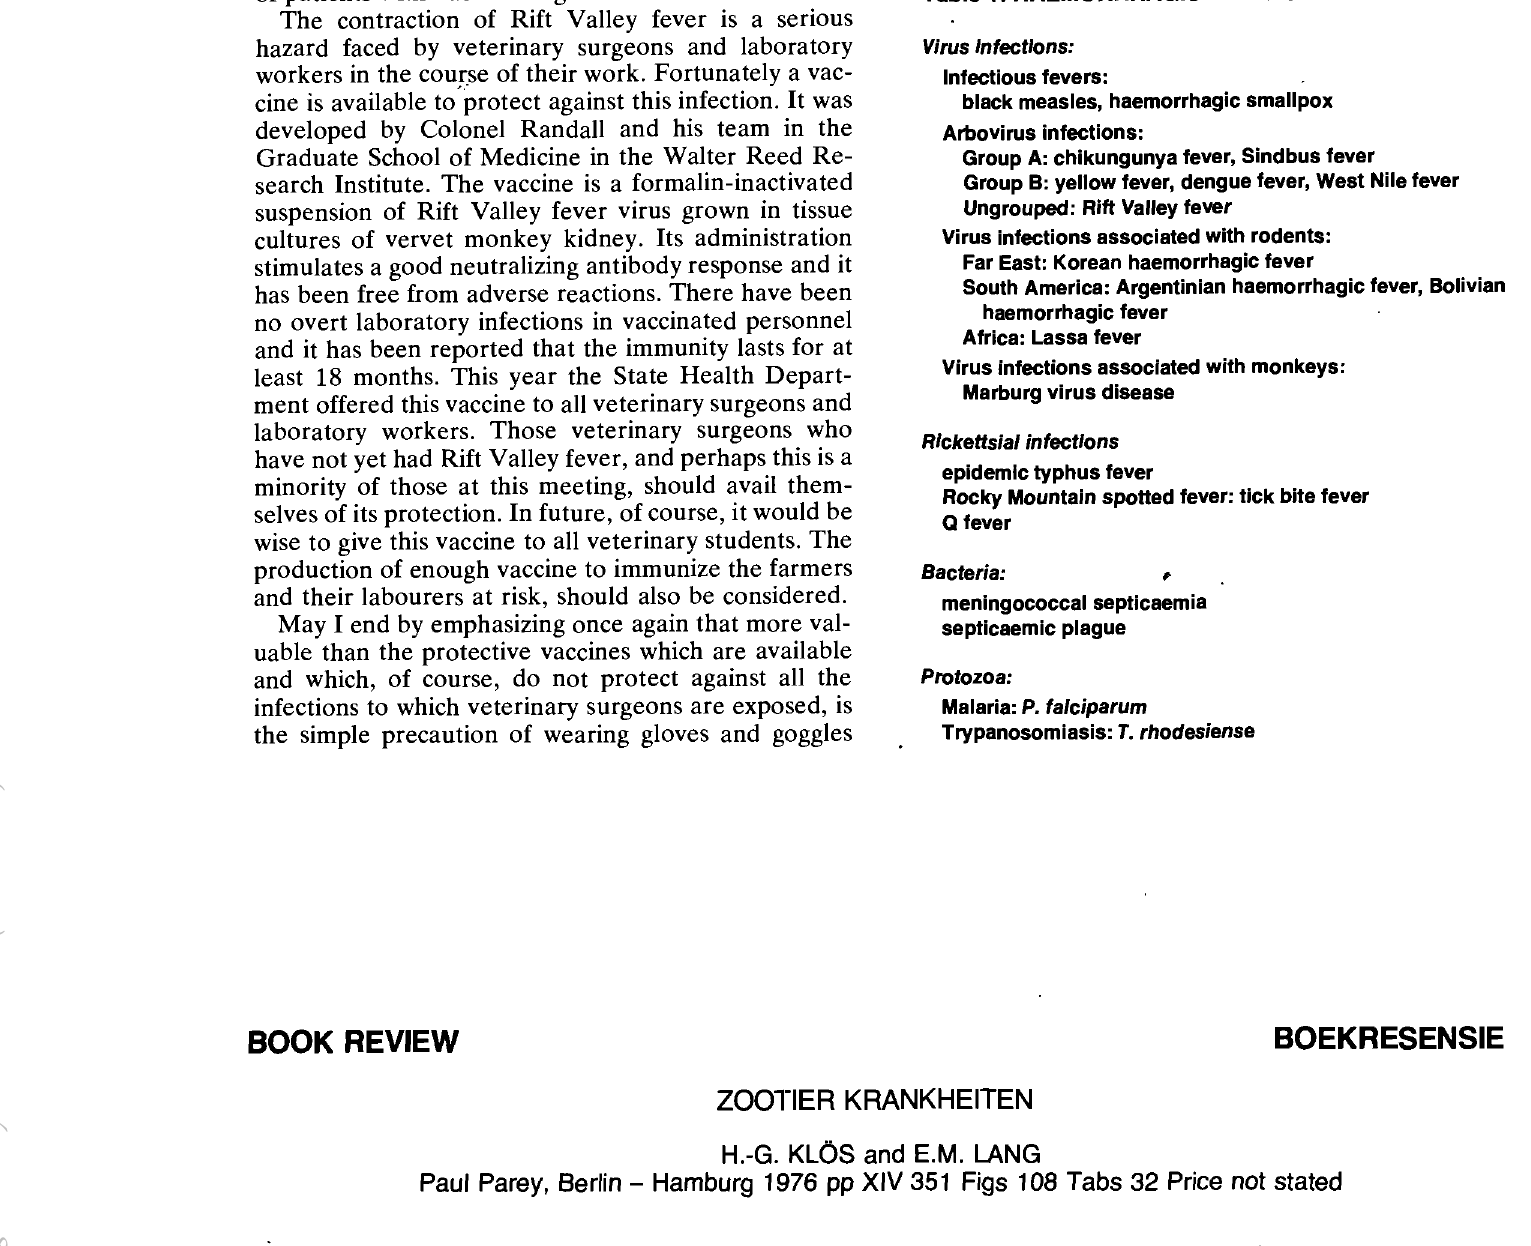
Table 1: HAEMORRHAGIC